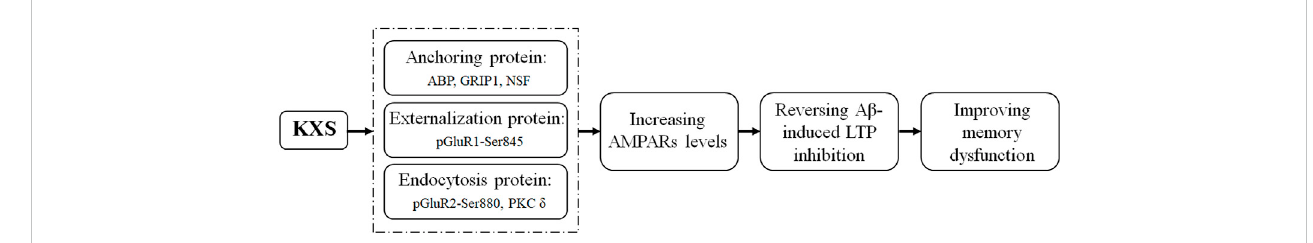
FIGURE 5 Illustration of the mechanism underlying KXS attenuation of memory impairment induced by A β